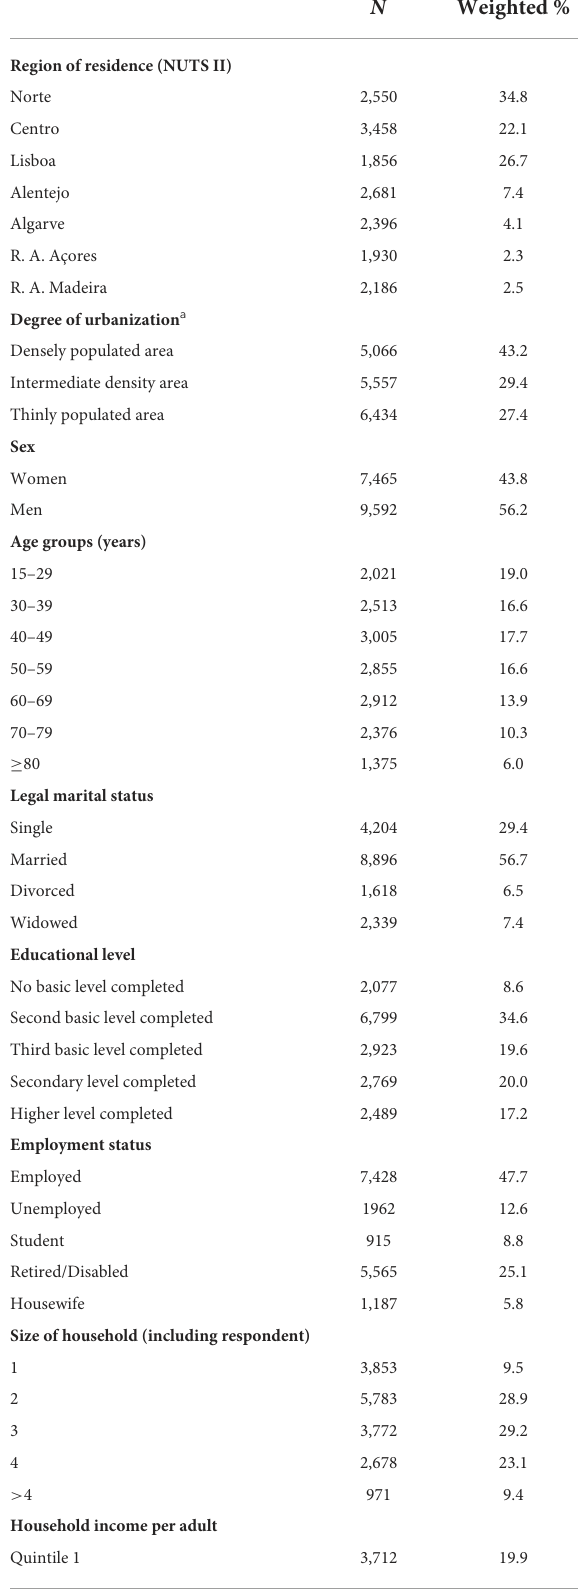
TABLE 1 Characteristics of the study sample ( n =